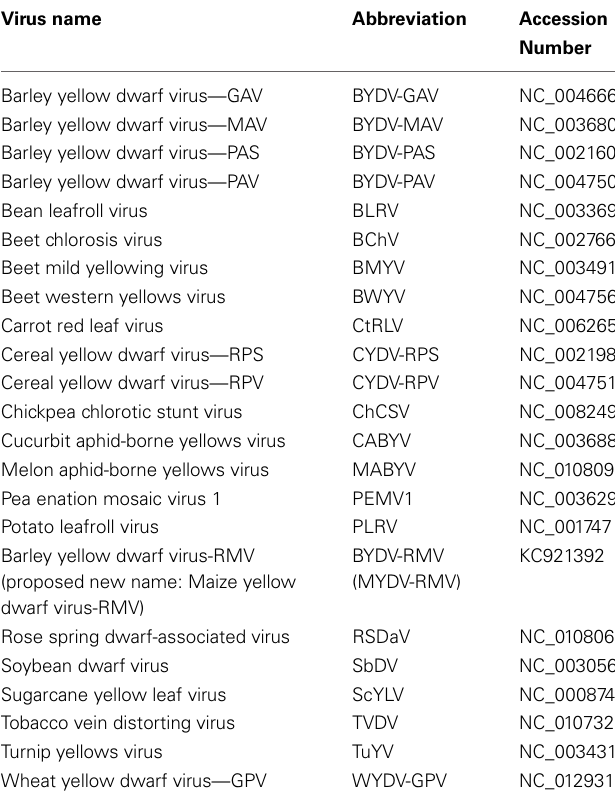
Table 1 | Virus abbreviations and GenBank accession numbers for viruses used for sequence comparisons in this